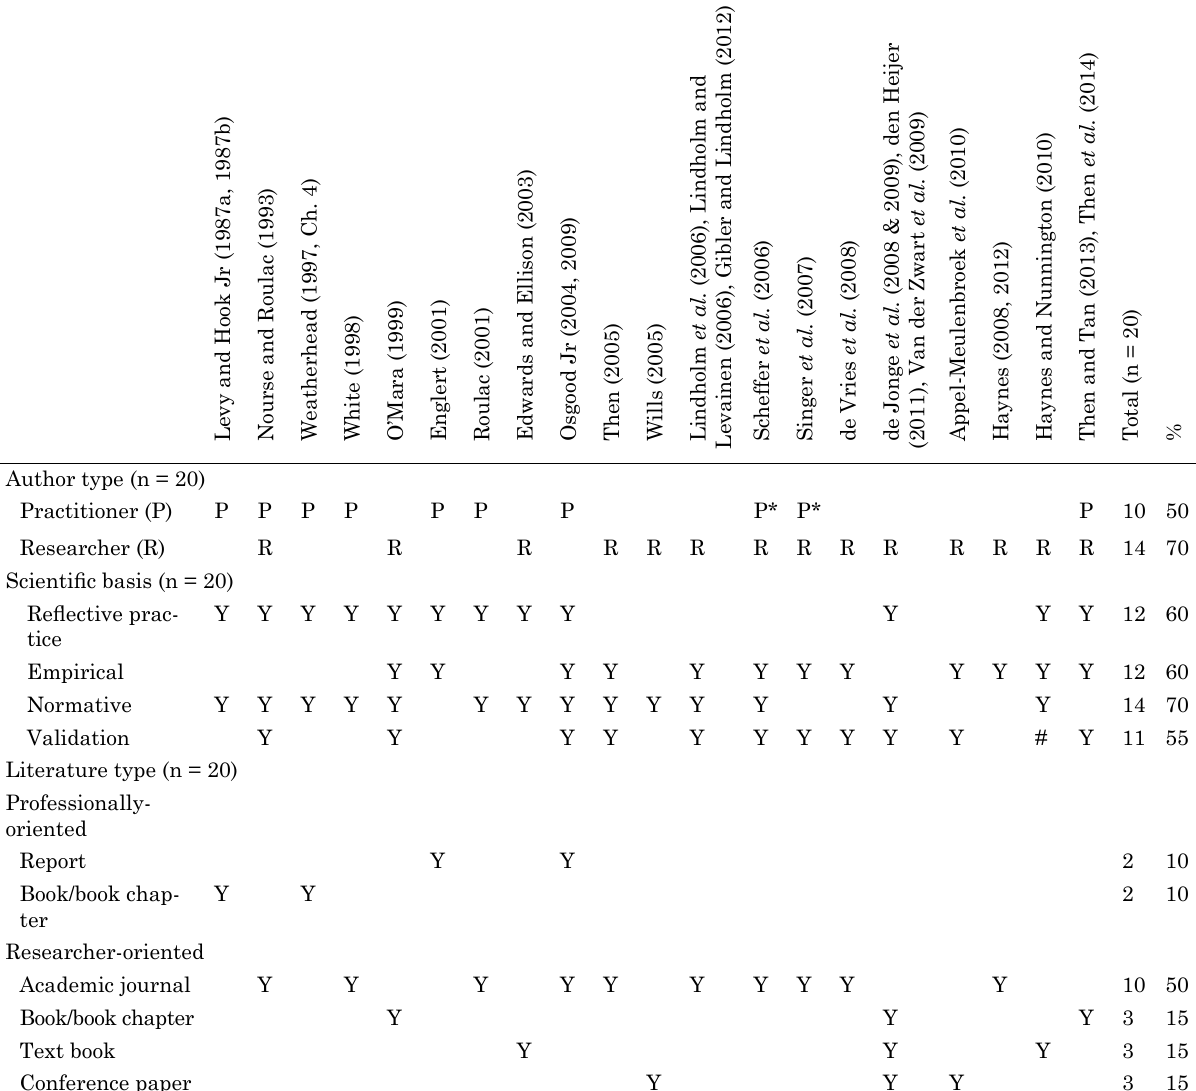
Table 6. Identifying the origins and scientific bases of CRE alignment